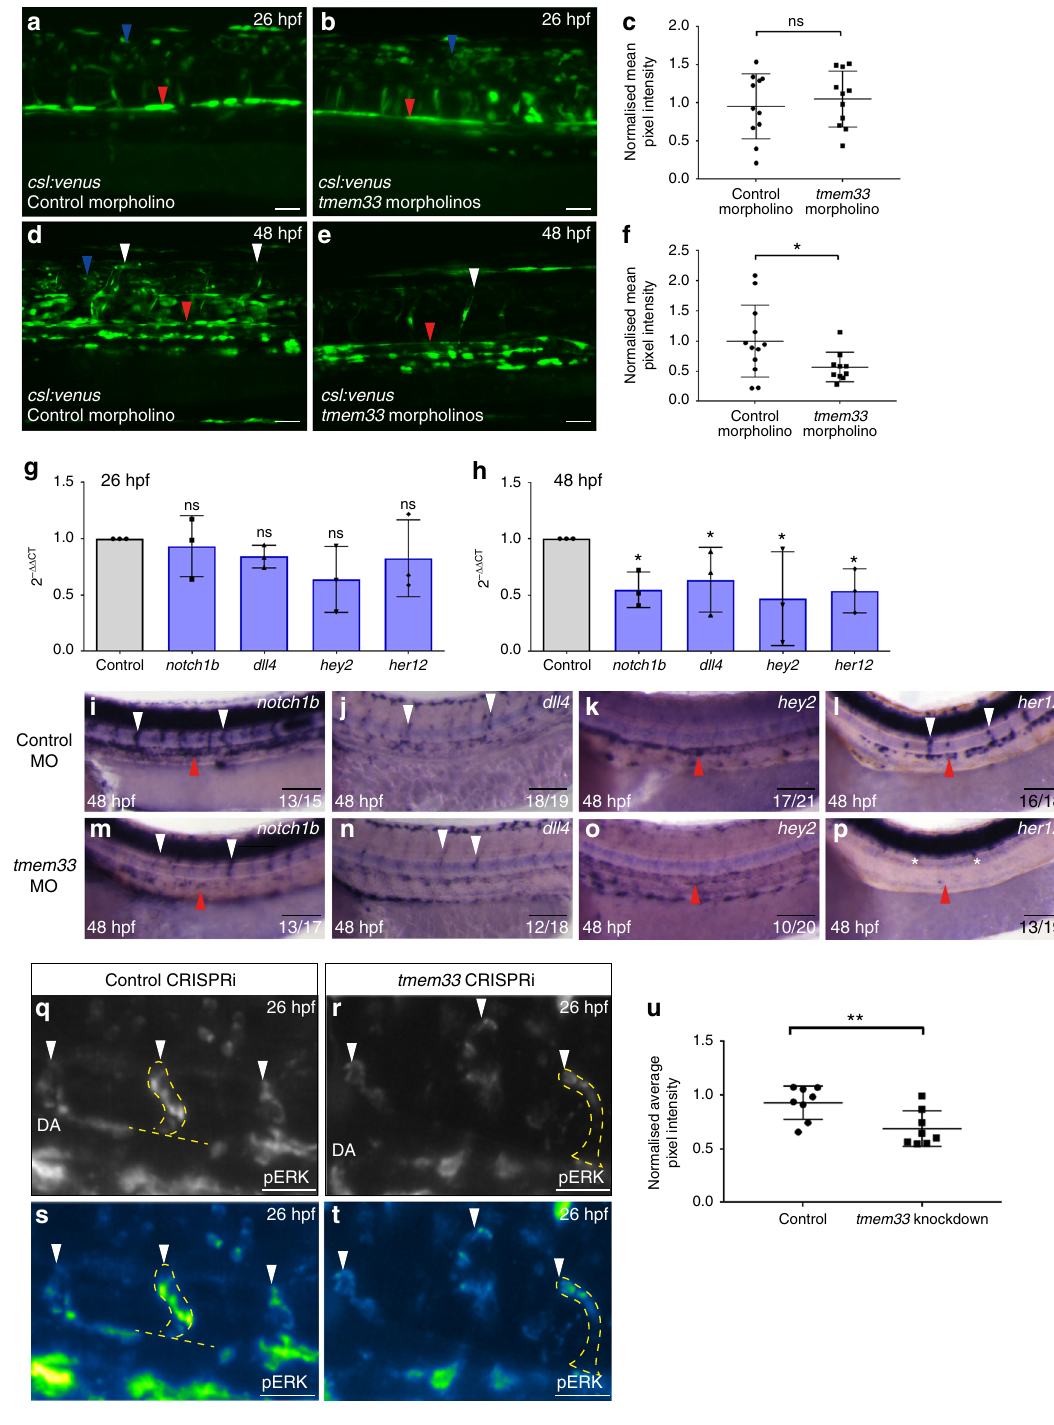
fi lopodia number (Fig. 7n – p) was reduced in ECs following SKF- 96365 treatment similar to tmem33 knockdown (Fig. 6d – f and Fig. 2f-i, respectively). SKF-96365-treated embryos also displayed abnormal spade-shaped tip cell morphology (Fig. 7b, e, o, blue arrowheads) as induced by tmem33 knockdown (Fig. 1k, white arrowhead). Given the similar angiogenic defects induced by tmem33 knockdown and SKF-96365 treatment, we examined whether inhibition of SOCE could account for reduced EC number and migration previously observed in tmem33 mor- phants (Fig. 4f – h, and Supplementary Fig. 2). We treated embryos from 21 hpf until 30 hpf and quanti fi ed EC proliferation